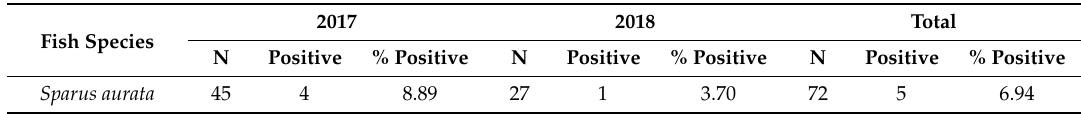
Table 6. Vibrio prevalence in the cultured fish S. aurata from the Mediterranean Sea farmed fish. The results are based on PCR targeting 16S rRNA segments. Positive result refers to one or more isolated tissue.